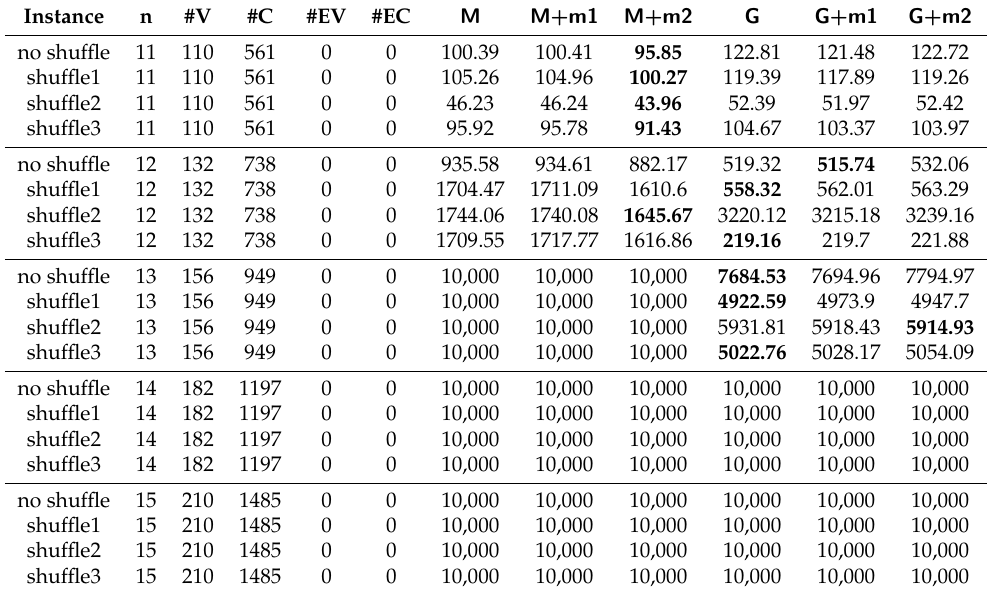
Table 1. Results of vanilla PHP instances.